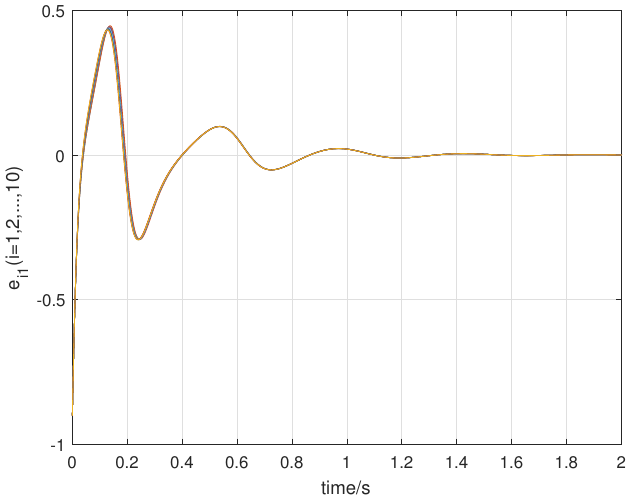
Figure 6. Trajectories of synchronization errors e j 1 ( 1 ≤ j ≤ 10 ) for the complex networks (77) and (80) with 10 fractional order nodes with time variance.